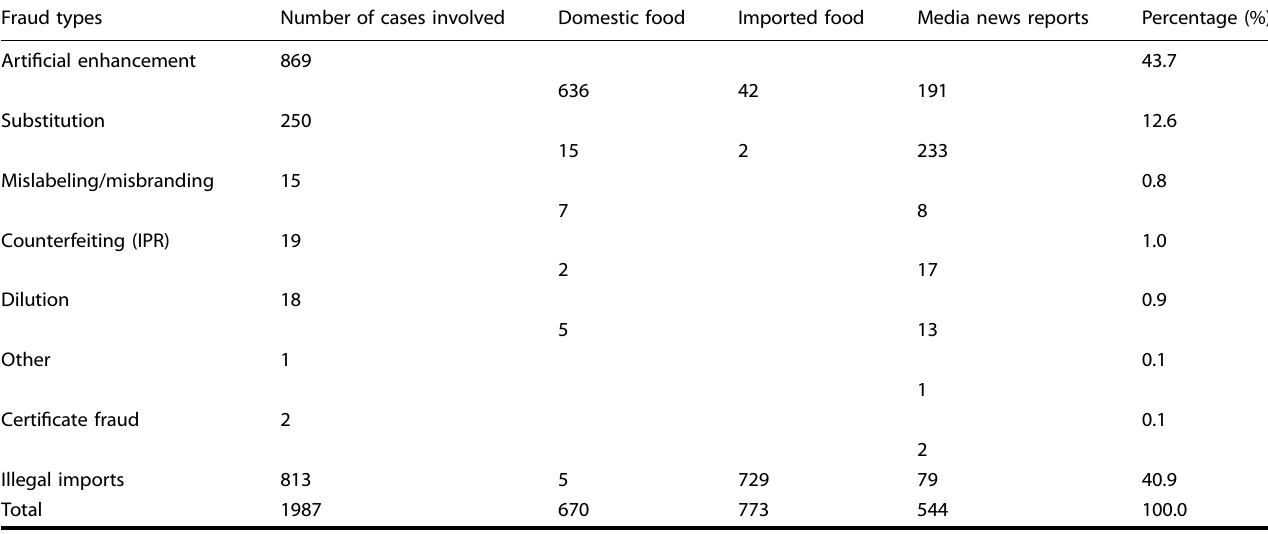
Table 1. Statistics on the number of each fraud type in meat